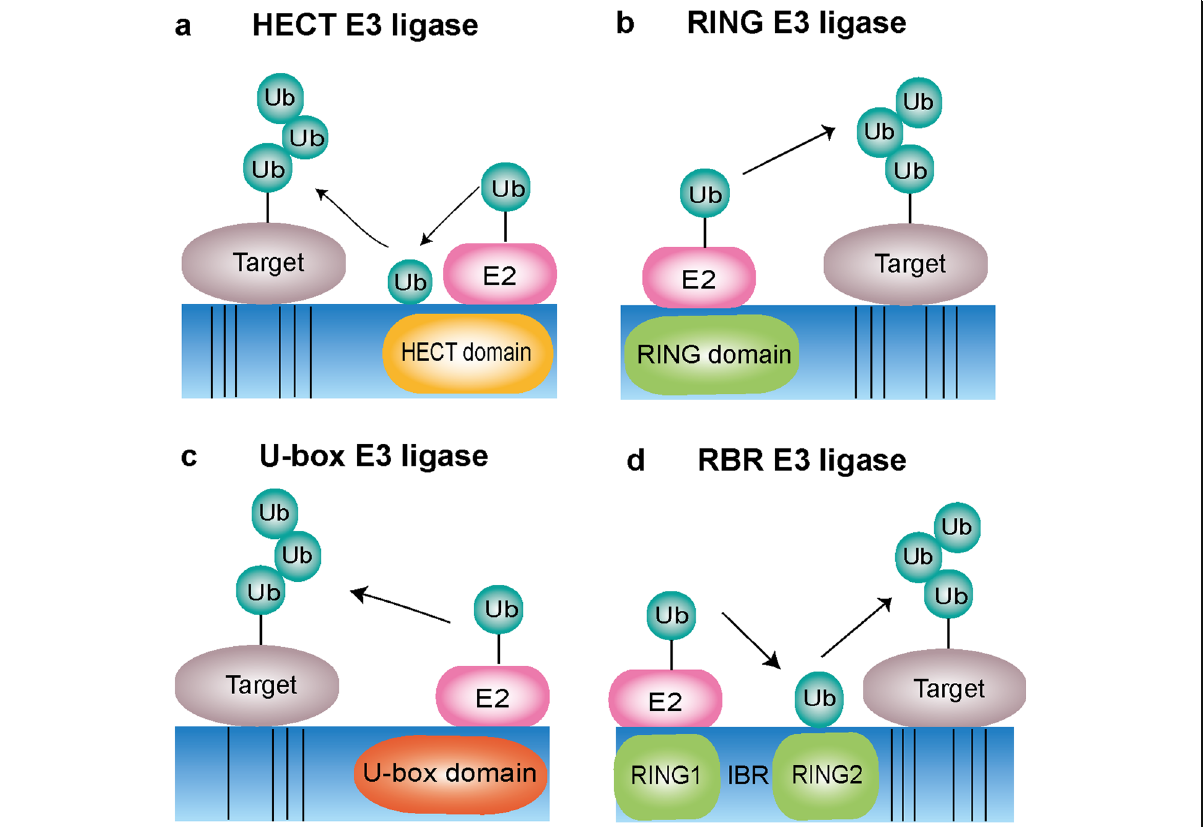
Fig. 3 Types of ubiquitination ligases. a The HECT type E3 ligases contain the conserved C-terminal HECT domain and the N-terminal consists with different domains depending the specific subtype. HECT type E3 ligases involved ubiquitination process including a two-step reaction: ubiquitin is first carried by E2 ligase binding to the HECT domain and then transferred to a catalytic cysteine on the E3 ligase, the second step is the transfer of ubiquitin from the E3 ligase to the substrate. b The RING type E3 ligases are characterized by the presence of a zinc-binding domain called RING at the N-terminal. RING E3s mediate a direct transfer of ubiquitin from E2 ligase to the substrate. c The U-box type E3 ligases contain U-box domain at the C-terminal which is responsible for binding the ubiquitin-charged E2 ligase and stimulating ubiquitin transfer. d The RBR type E3 ligases consist of two predicted RING domains (RING1 and RING2) separated by IBR domain . RBR E3 ligases catalyzed ubiquitination process involves a two-step reaction where ubiquitin is first transferred to a catalytic RING2 domain on the E3 and then to the